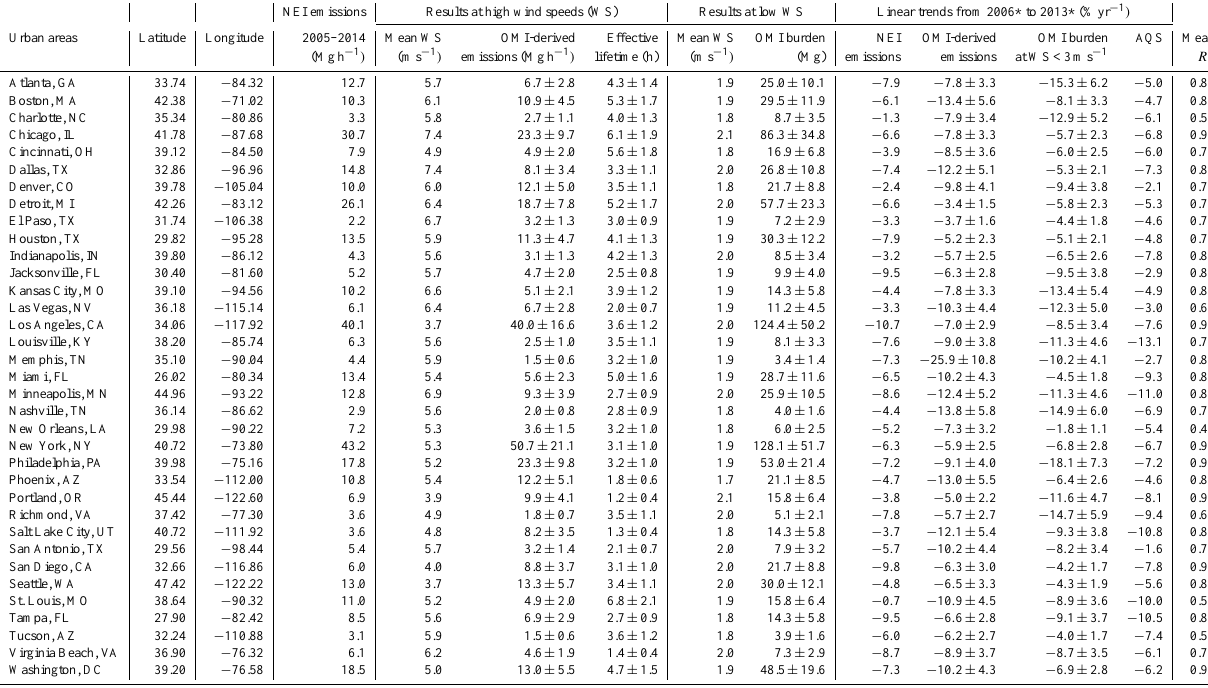
Table 1. Summary of the average bottom-up NO x emissions, OMI-derived NO x results, ground-based NO 2 measurements, and their linear trends for 35 US urban areas during the summer half-year (April–September) from 2006* to 2013* a